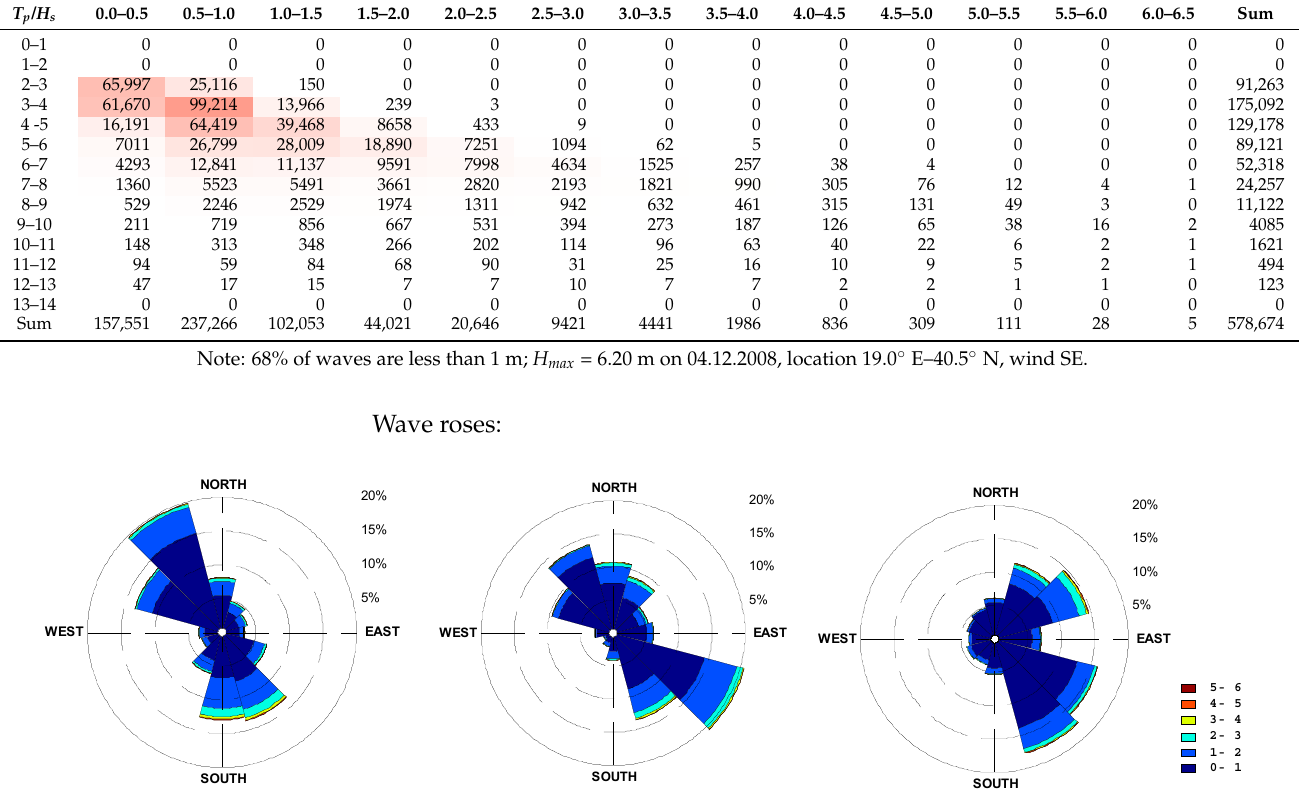
19 of 24 Table A6. Sea table for South Adriatic region (locations 22–39).